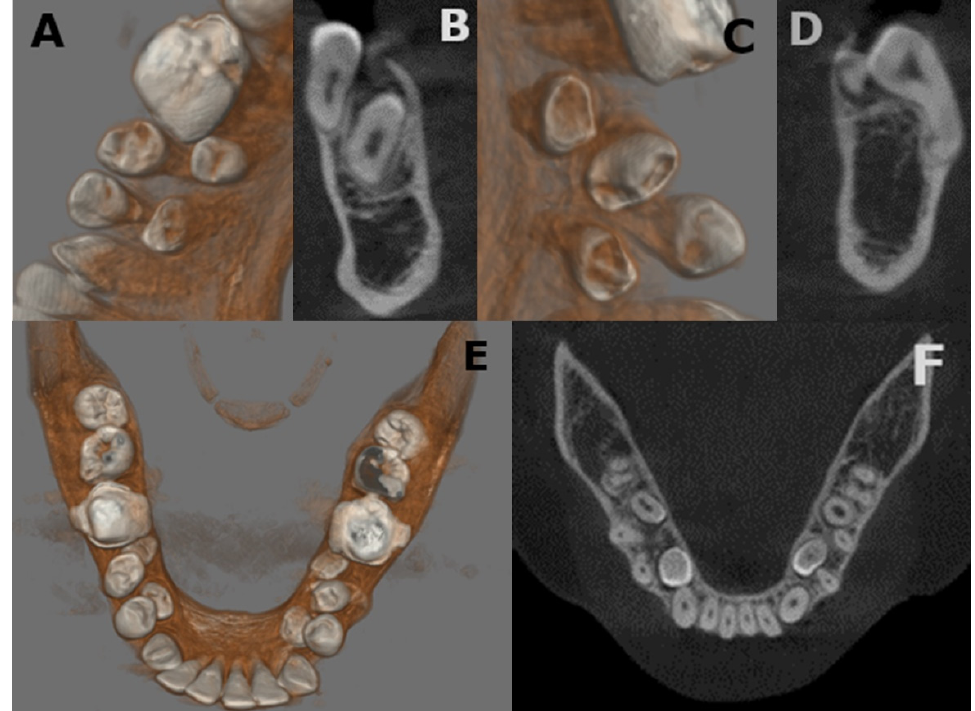
Figure 10 ( A – F ). CBCT findings of a 21-year-old: ( A – D ) rendering and axial slices of supplementary inferior premolars; ( E ) rendering of mandibular view; ( F ) coronal slices. Lingual position of the lower impact teeth in areas 4.4–4.5 and 3.4–3.5.